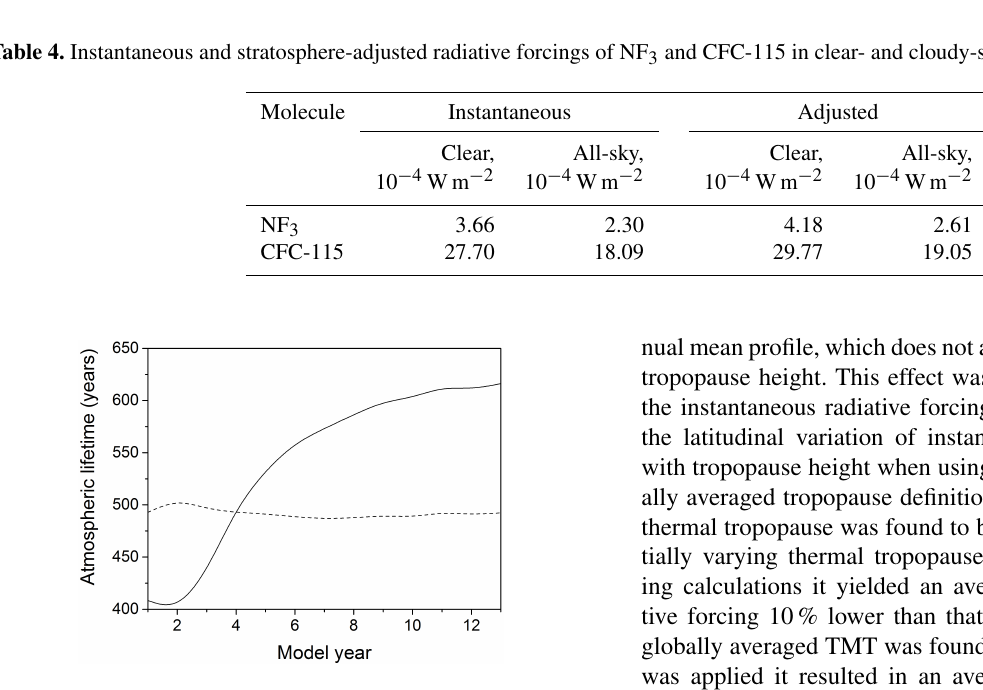
Figure 5. Annually averaged atmospheric lifetimes for NF 3 (solid line) and CFC-115 (dashed line) as a function of simulation